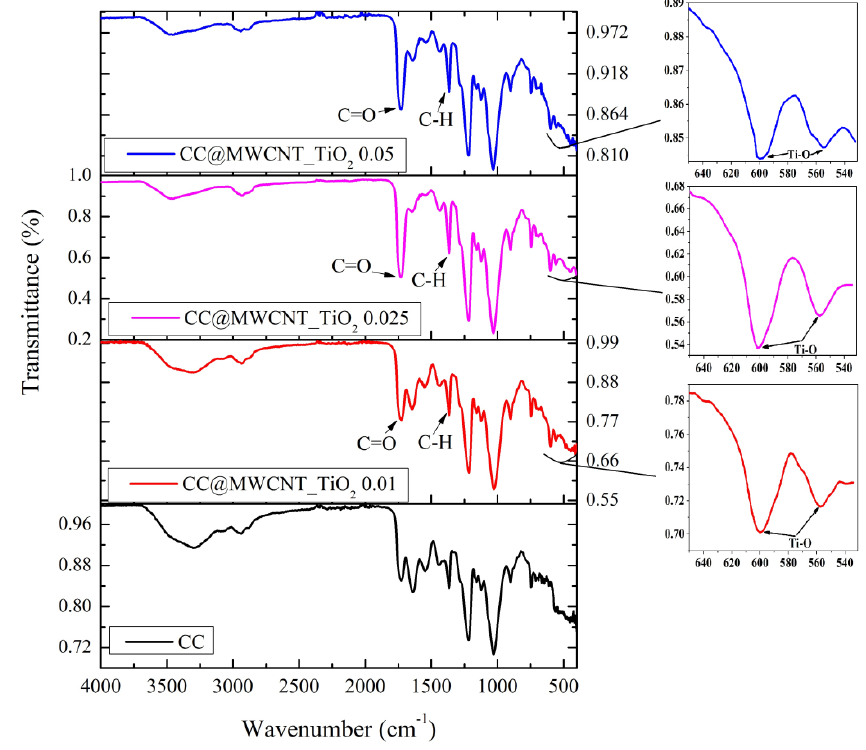
Figure 5. FTIR spectra of the obtained films